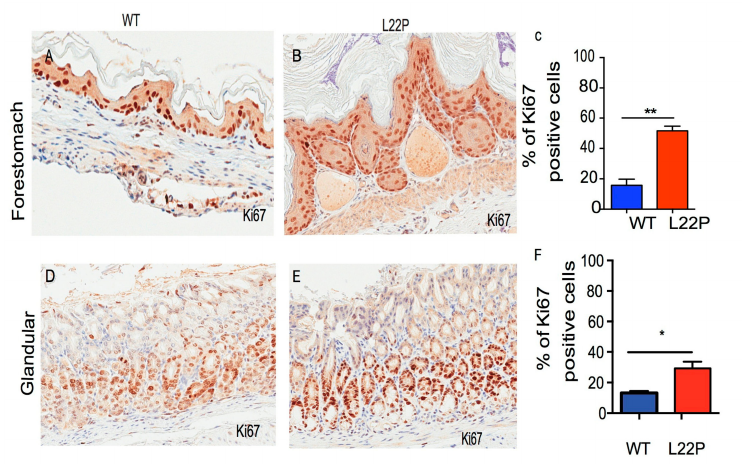
Figure 2. L22P mutation induces cellular proliferation in mice. ( A , B ) Representative image of forestomach tissue sectioned from wild type (WT) and L22P mice stained with Ki67 antibody proliferation